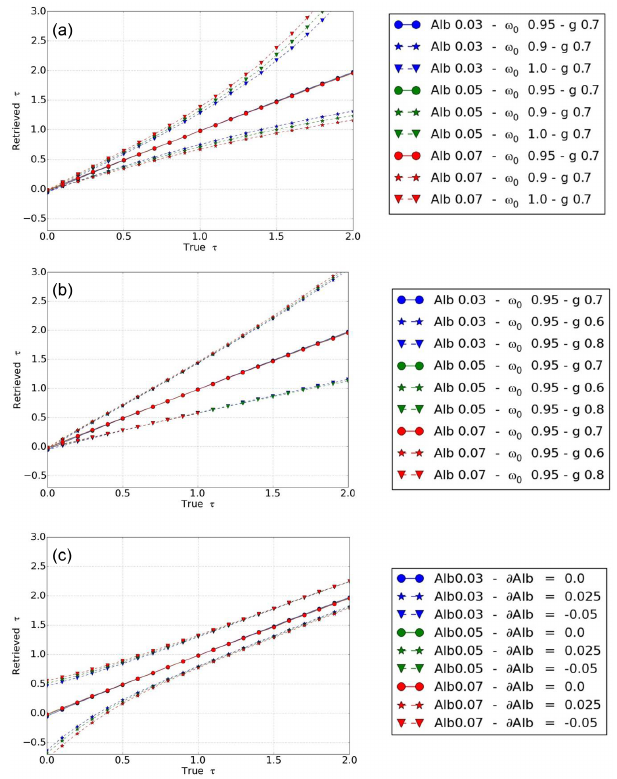
Figure 4. Simulated τ (550nm) retrievals, based on noise-free syn- thetic spectra with aerosols, as a function of true τ( 550nm ) . The assumed geophysical conditions are temperature, H 2 O, O 3 and NO 2 from climatology mid-latitude summer; θ 0 = 25 ◦ , θ = 25 ◦ and P s = 1010hPa. All particles are located between 800 and 900hPa and α = 1.5. Note that the scenarios with lines and similar sym- bols general tend to fall on top of each other. The reference aerosol scenario is plotted with continuous lines and circle symbols and includes consistent aerosol optical properties with the supervision data set used to train the neural network algorithm: i.e. ω 0 = 0.95, g = 0.7. All the retrievals are achieved with the NN algorithm trained with ω 0 = 0.95: (a) sensitivity of τ (550nm) retrievals to the aerosol single scattering albedo (true ω 0 = 0.95, 0.9 or 1.0); (b) sen- sitivity of τ (550nm) retrievals to the aerosol asymmetry parameter (true g = 0.6, 0.7 or 0.8); (c) sensitivity of τ (550nm) retrievals to a surface albedo bias ( ∂ Alb = 0.0, 0.025, − 0.05) with ω 0 = 0.95, g =